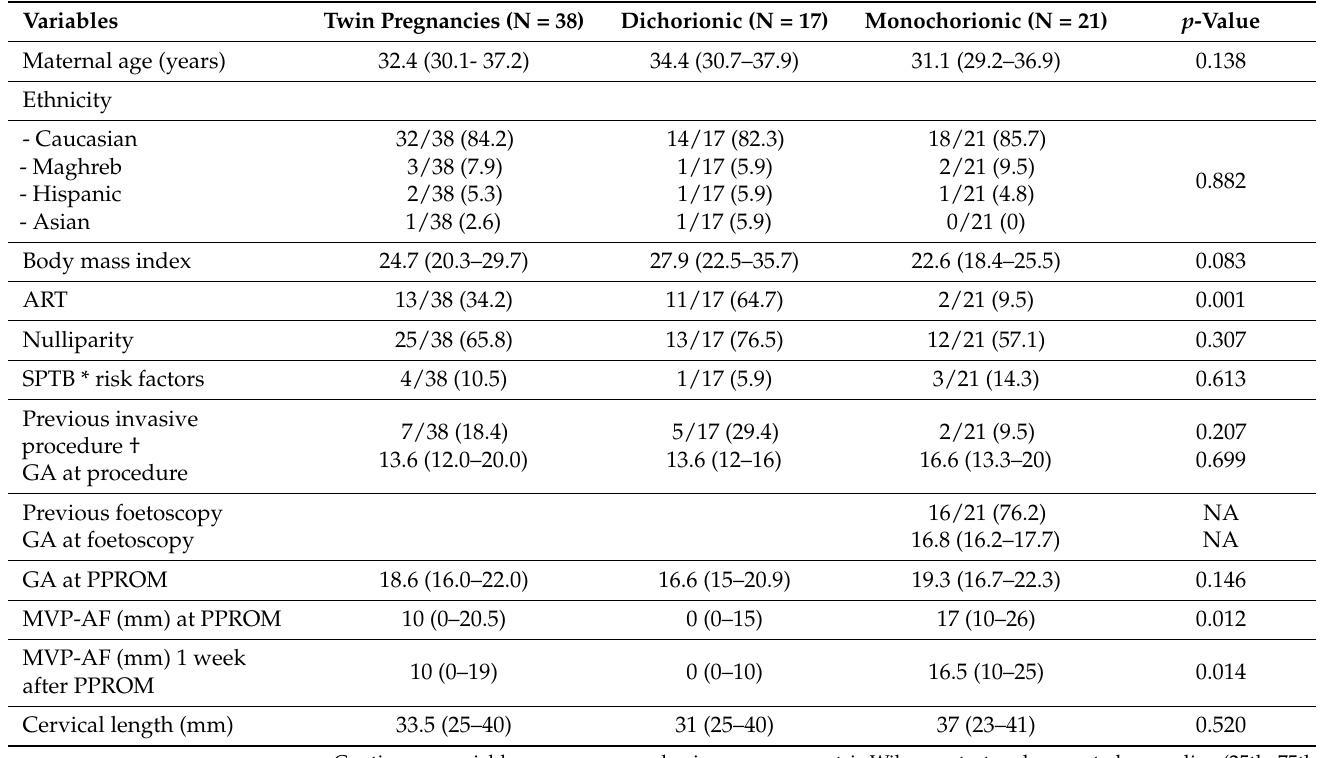
Table 1. Maternal and gestational